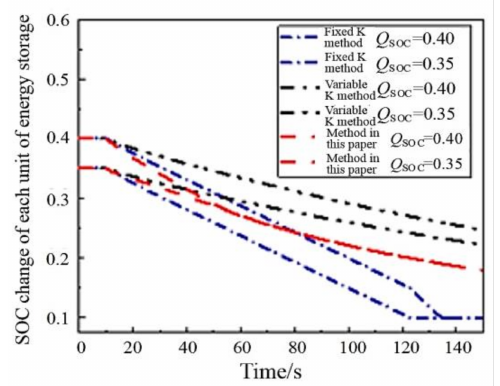
Figure 6. SOC changes with and without